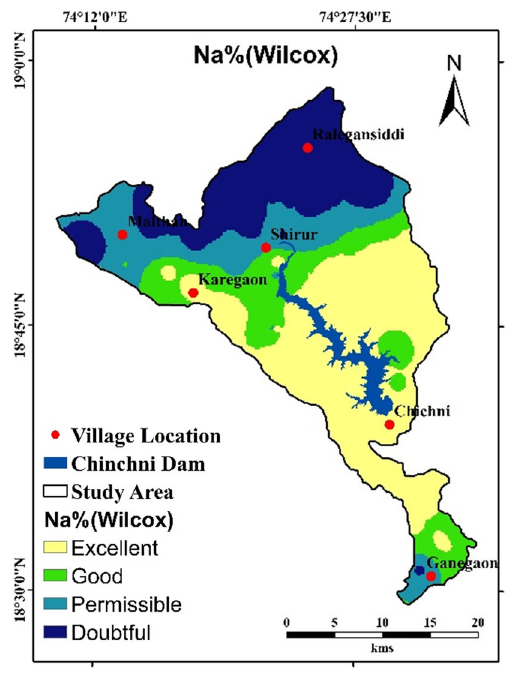
Fig. 11 Spatial variation in Na% (Wilcox